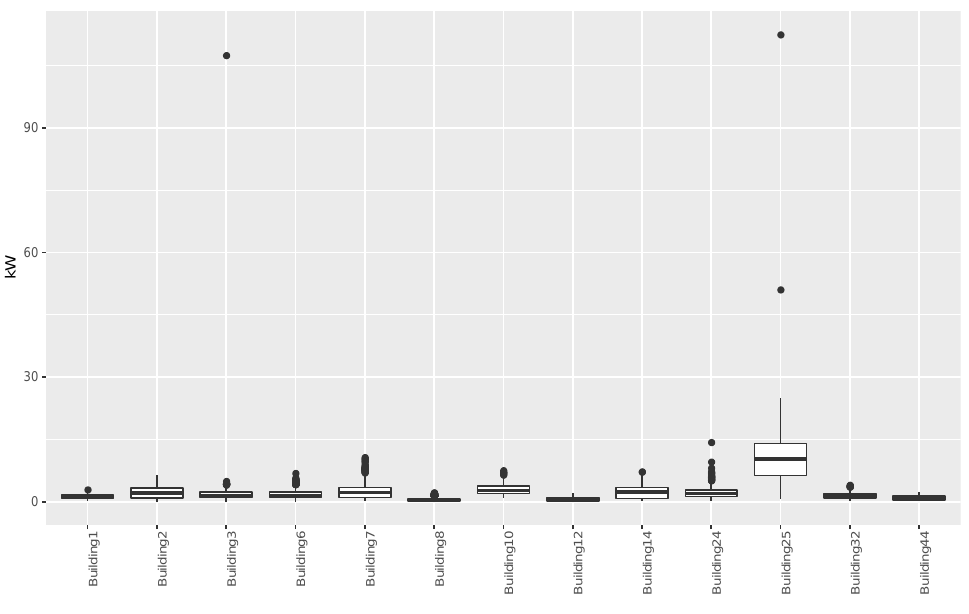
Figure 2. Distribution of values for the different buildings.